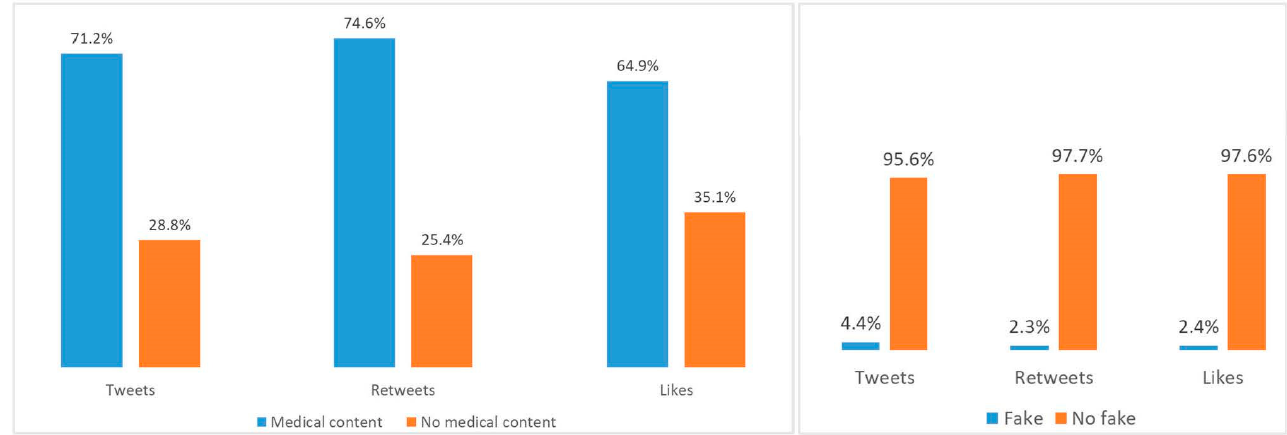
Figure 1. ( Left ): Number of tweets, retweets, and likes generated by medical (blue columns) or non-medical content (orange columns). ( Right ): Number of tweets of medical content, retweets, and likes generated by whether its medical content is fake or not. Table 2. Number of tweets with medical contents and of those with fake information related to the rheumatic diseases.